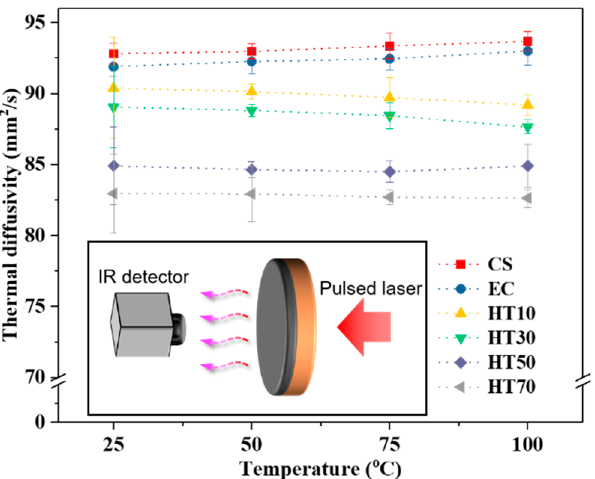
Figure 5. Thermal diffusivity of electrodeposited copper surface (CS) and electrodeposited copper surface (EC) with heat treatment for 10 min (HT10), 30 min (HT30), 50 min (HT50), and 70 min (HT70) measured at 25–100 °C.